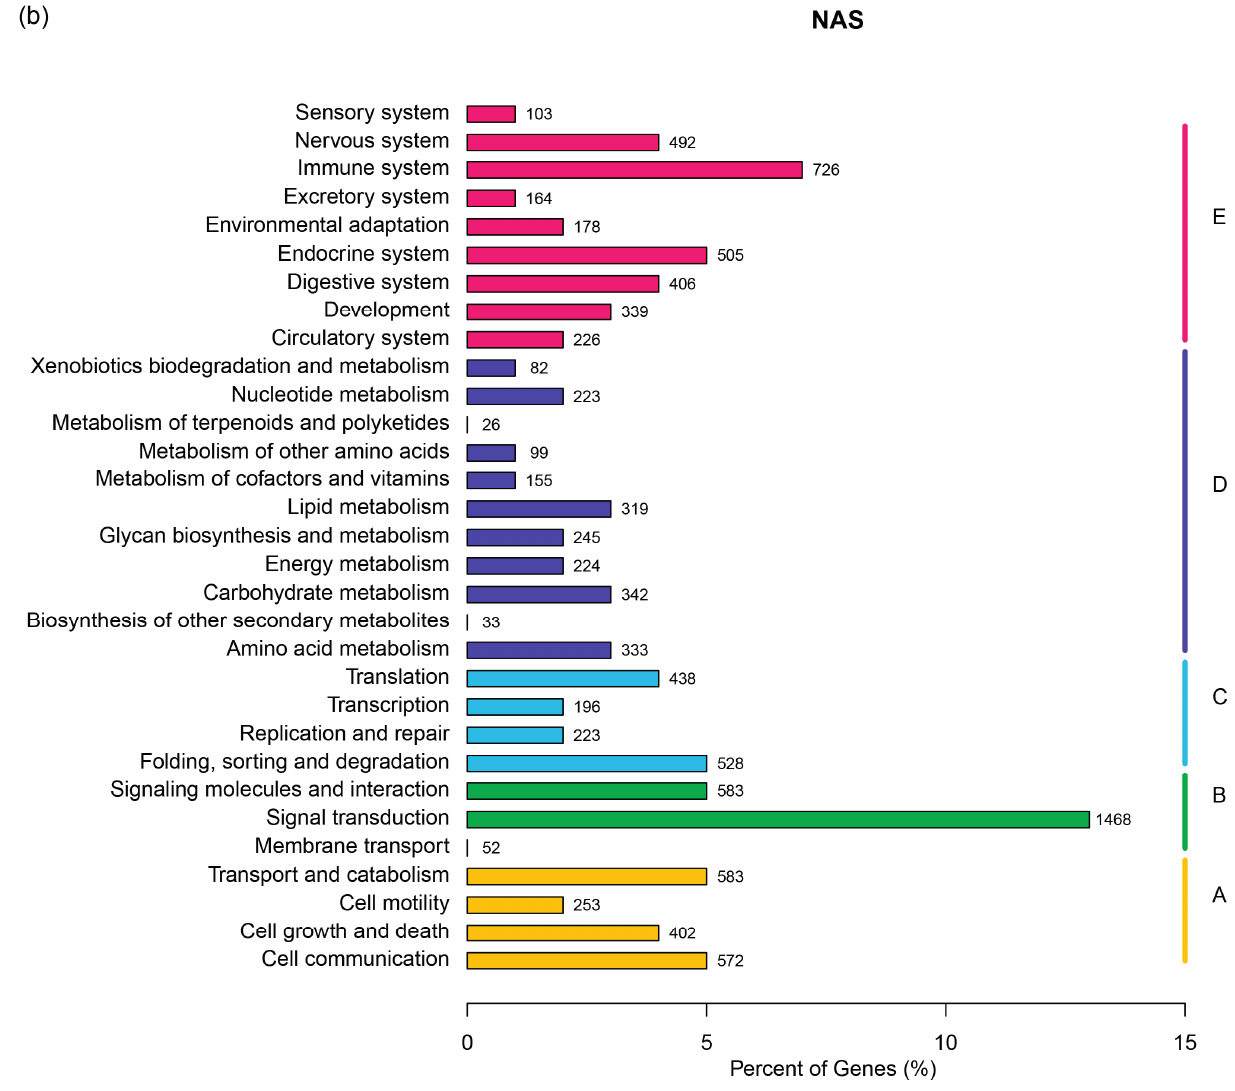
Figure 2. KEGG pathway classification of unigenes. ( a ) NAA; ( b ) NAS. The KEGG pathways were categorized into five groups, A: Cellular process, B: Environmental information processing, C: Genetic information processing, D: Metabolism and E: Organismal system. KEGG: Kyoto Encyclopedia of Genes and Genomes; NAS: the East Asian finless porpoise; NAA: the Yangtze finless porpoise. Table 3. The number of unigenes involved in the osmoregulatory process by KEGG pathways classification analysis. KEGG: Kyoto Encyclopedia of Genes and Genomes; NAS: the East Asian finless porpoise; NAA: the Yangtze finless porpoise. The Number of The Number of KEGG Pathway Unigenes in NAA Unigenes in